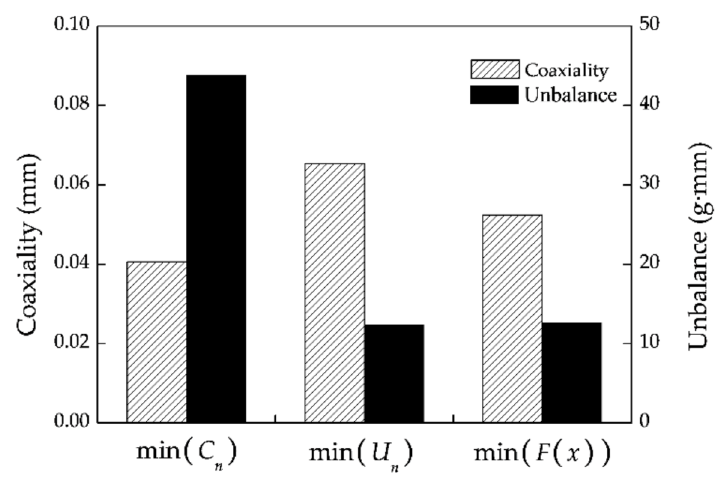
Figure 10. The calculated coaxiality and unbalance of the high-pressure rotor system based on the three different optimization objectives.